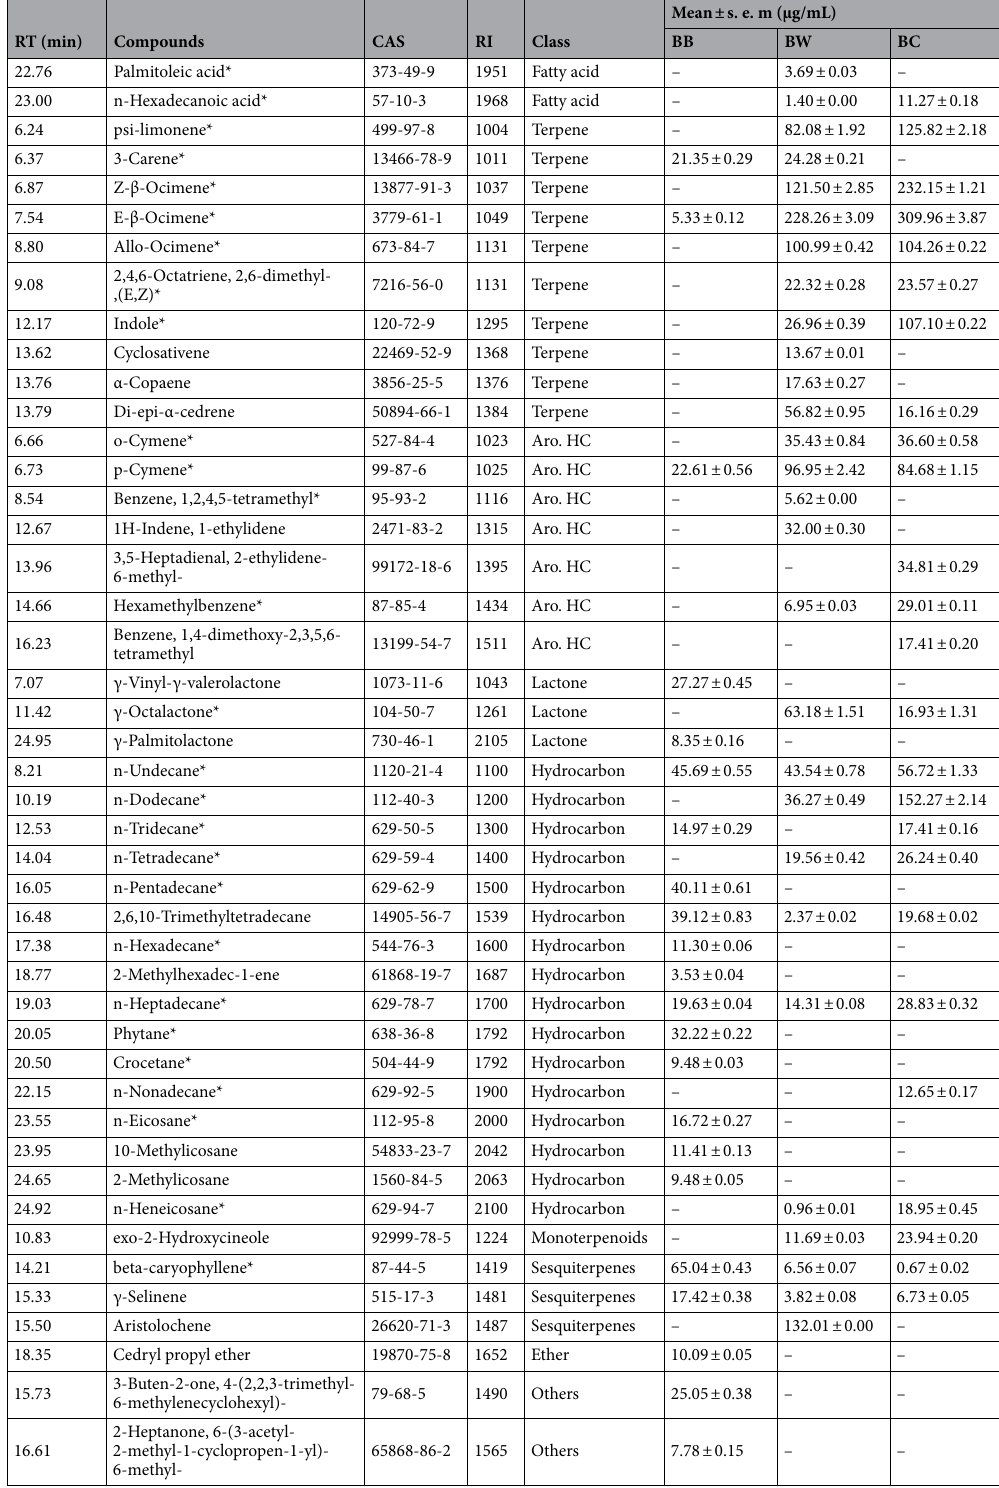
Table 1. List of volatile compounds identified from BB, BW and BC using GC–MS. RT (min) retention time in minutes, RI retention index, BB beehive with bees, BW beehive without bees, BC beehives with conspecific, s.e.m Standard error mean, *Compound identifications were verified using commercial synthetic standards (purchased from Sigma-Aldrich, India), Aro. HC aromatic